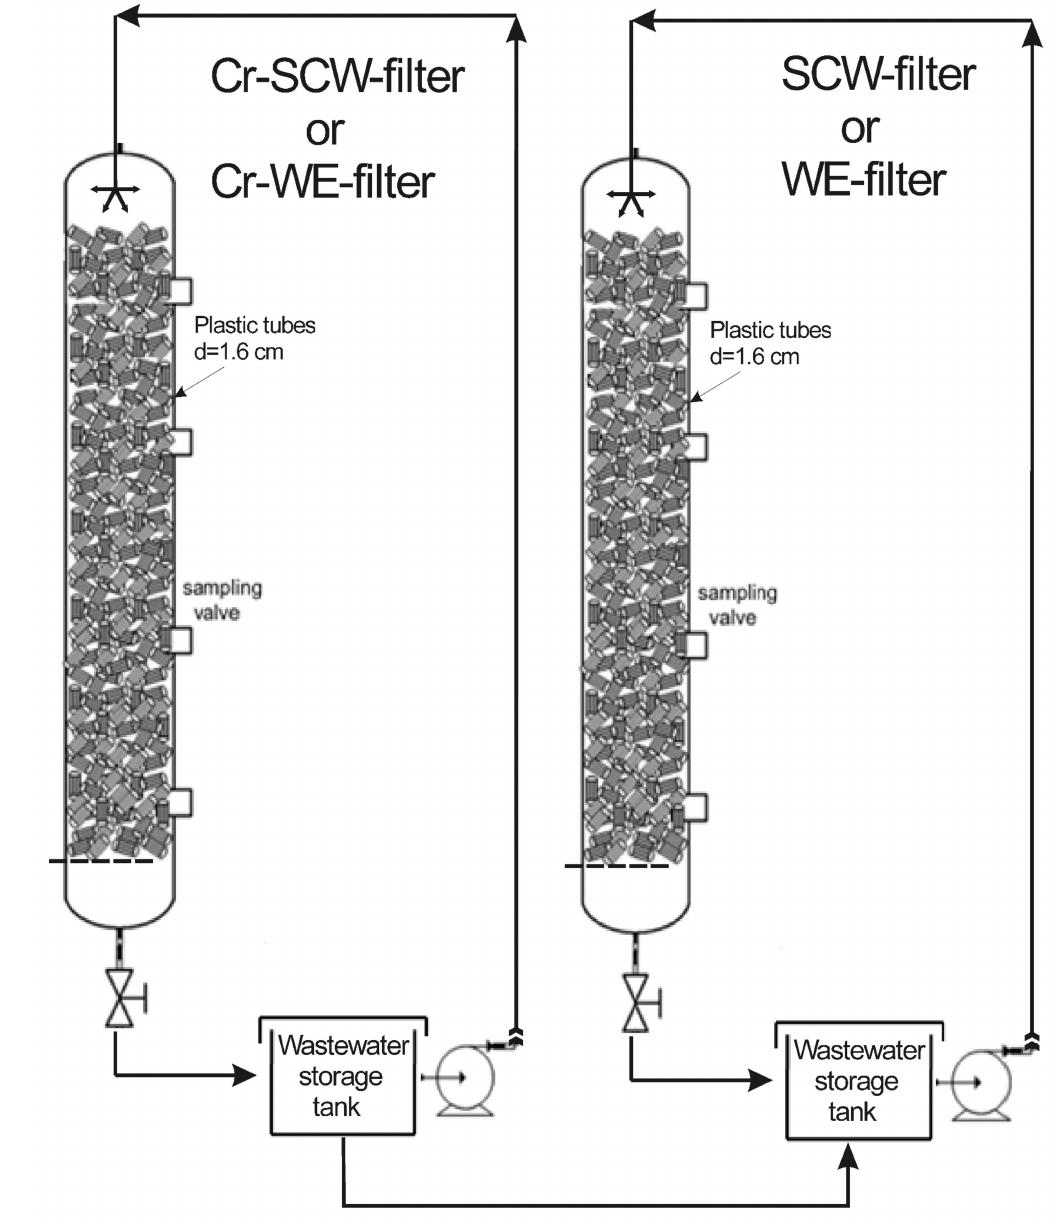
Figure 1. Scheme of the pilot-scale